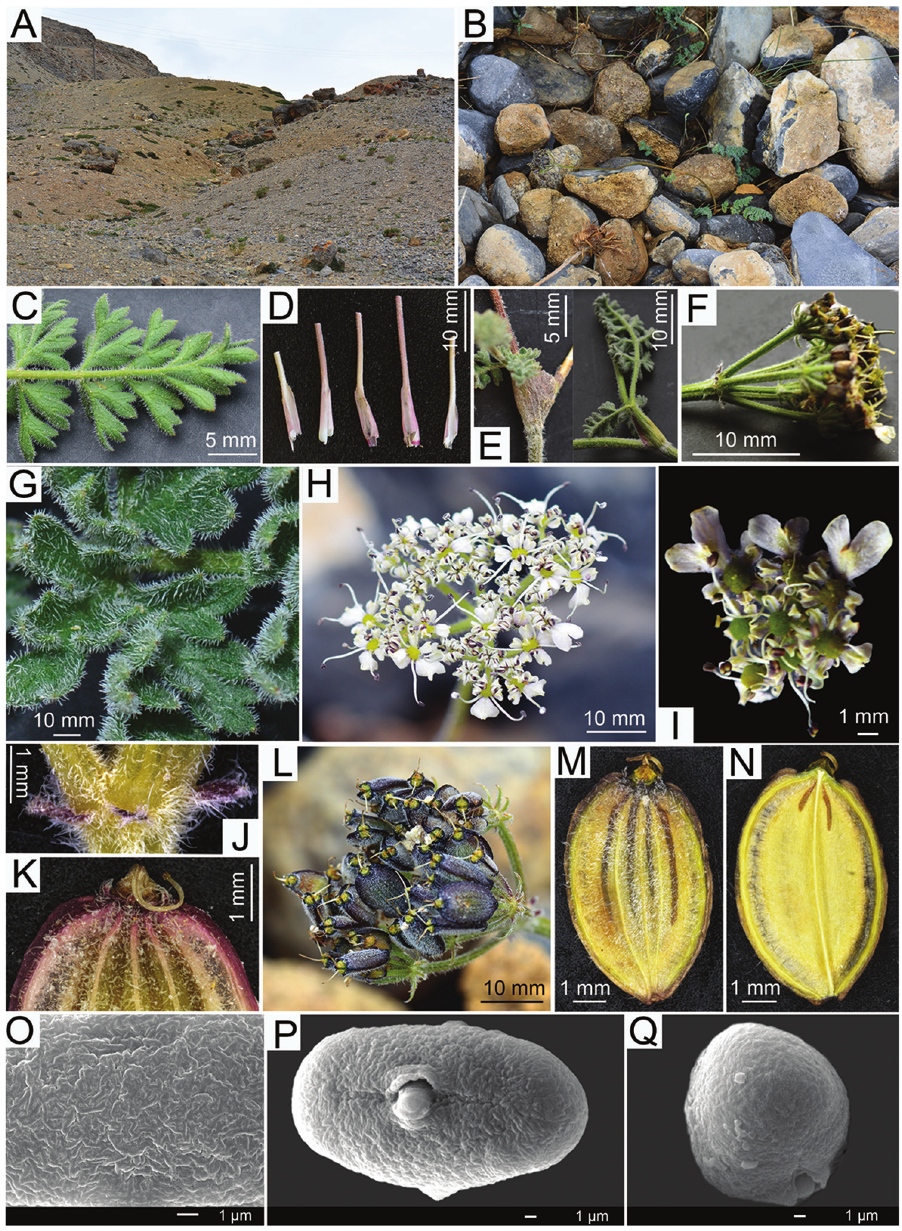
Figure 1. Semenovia gyirongensis A–B Habitat C Abaxial surface of primary pinnae D Basal leaf sheaths E Middle-upper cauline leaf sheaths F Rays G Adaxial surface of primary pinnae, showing hairs H Com- pound umbel I Umbellule J Bracts K Calyx teeth and stylopod L Infructescence M Dorsal side of meri- carp N Commissural side of mericarp O Cerebroid ornamentation on equatorial plane of pollen grain P Tricolporate Q Rounded pollen polar